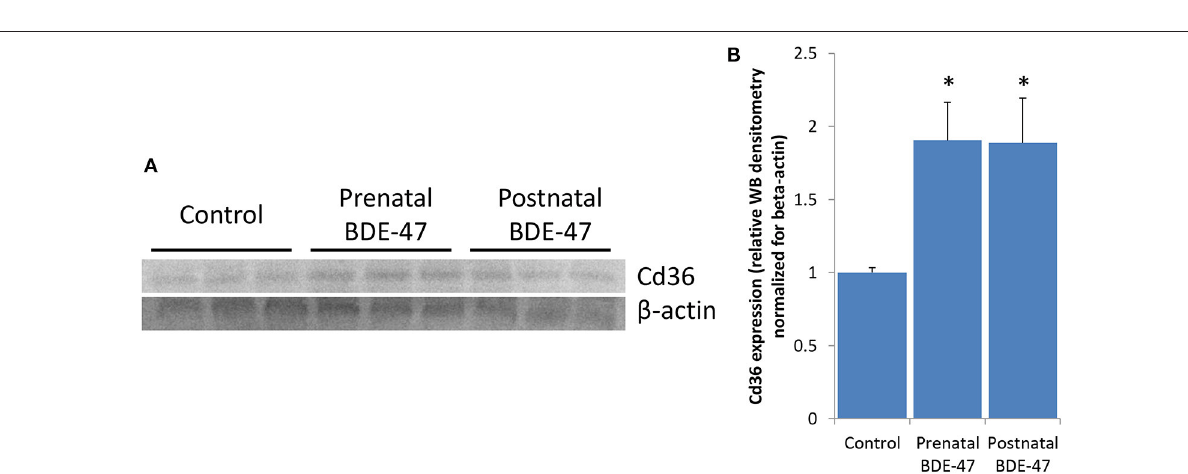
in Reanalysis of Published Transcriptional Datasets. The